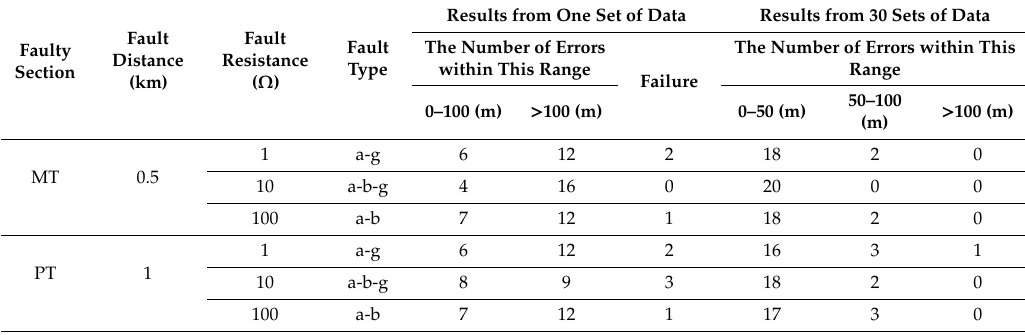
Table 6. The statistical results of the fault location in the case of ± 1% data